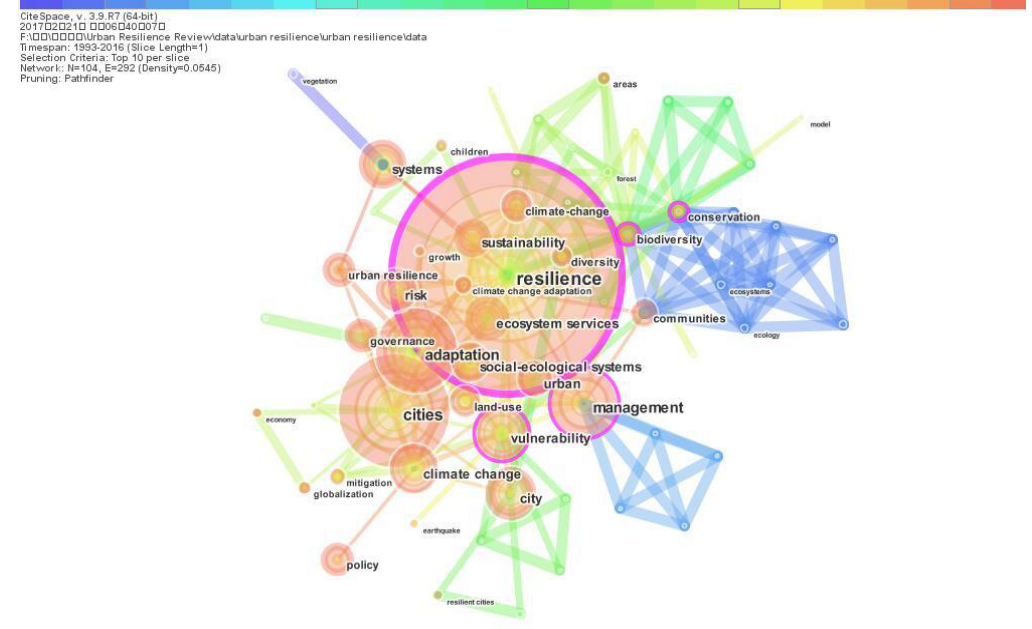
Figure 6. Co-occurring keywords network.